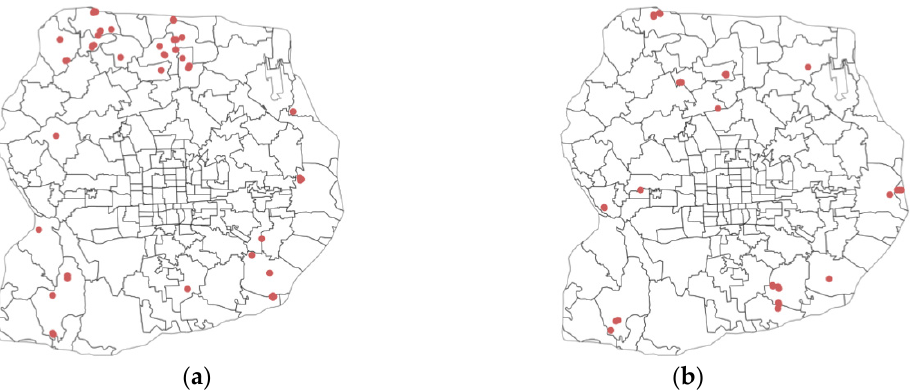
Figure 8. Querying residential apartment compounds with mismatched vibrancy characteristics. ( a ) Most residential with the lowest facility; ( b ) highest activeness with the lowest space